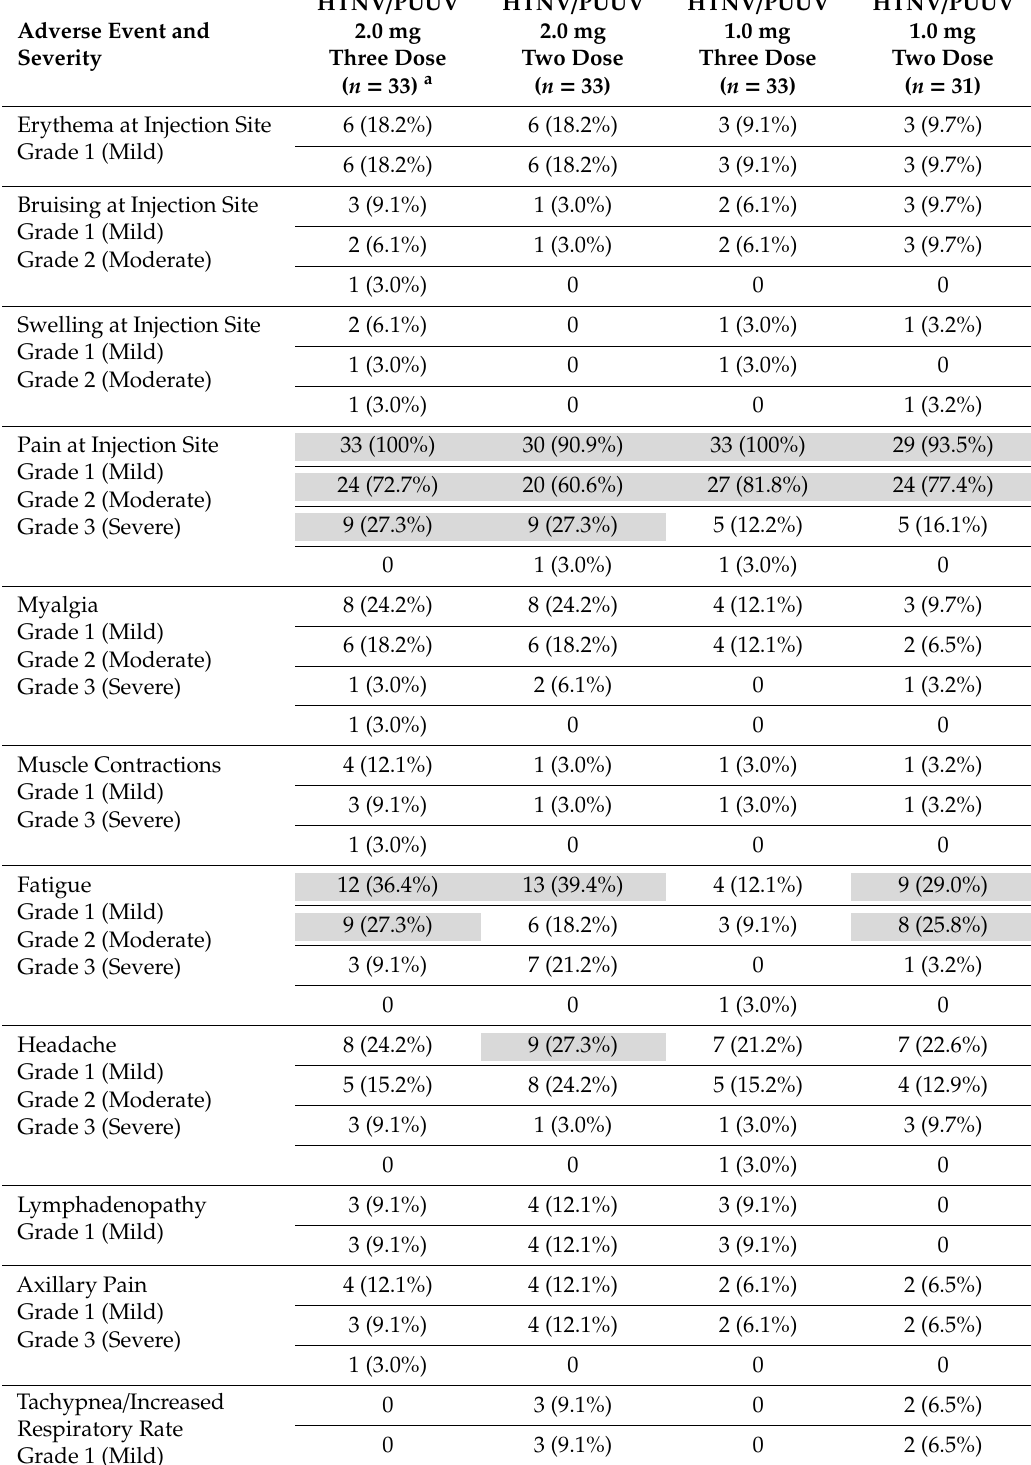
Table 2. Solicited adverse events for each